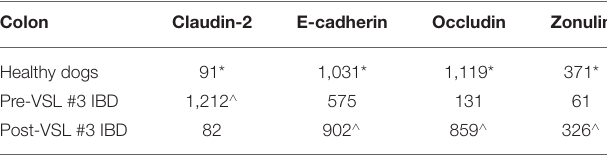
TABLE 4 | Probiotic therapy modulates TJP expression in dogs with IBD.